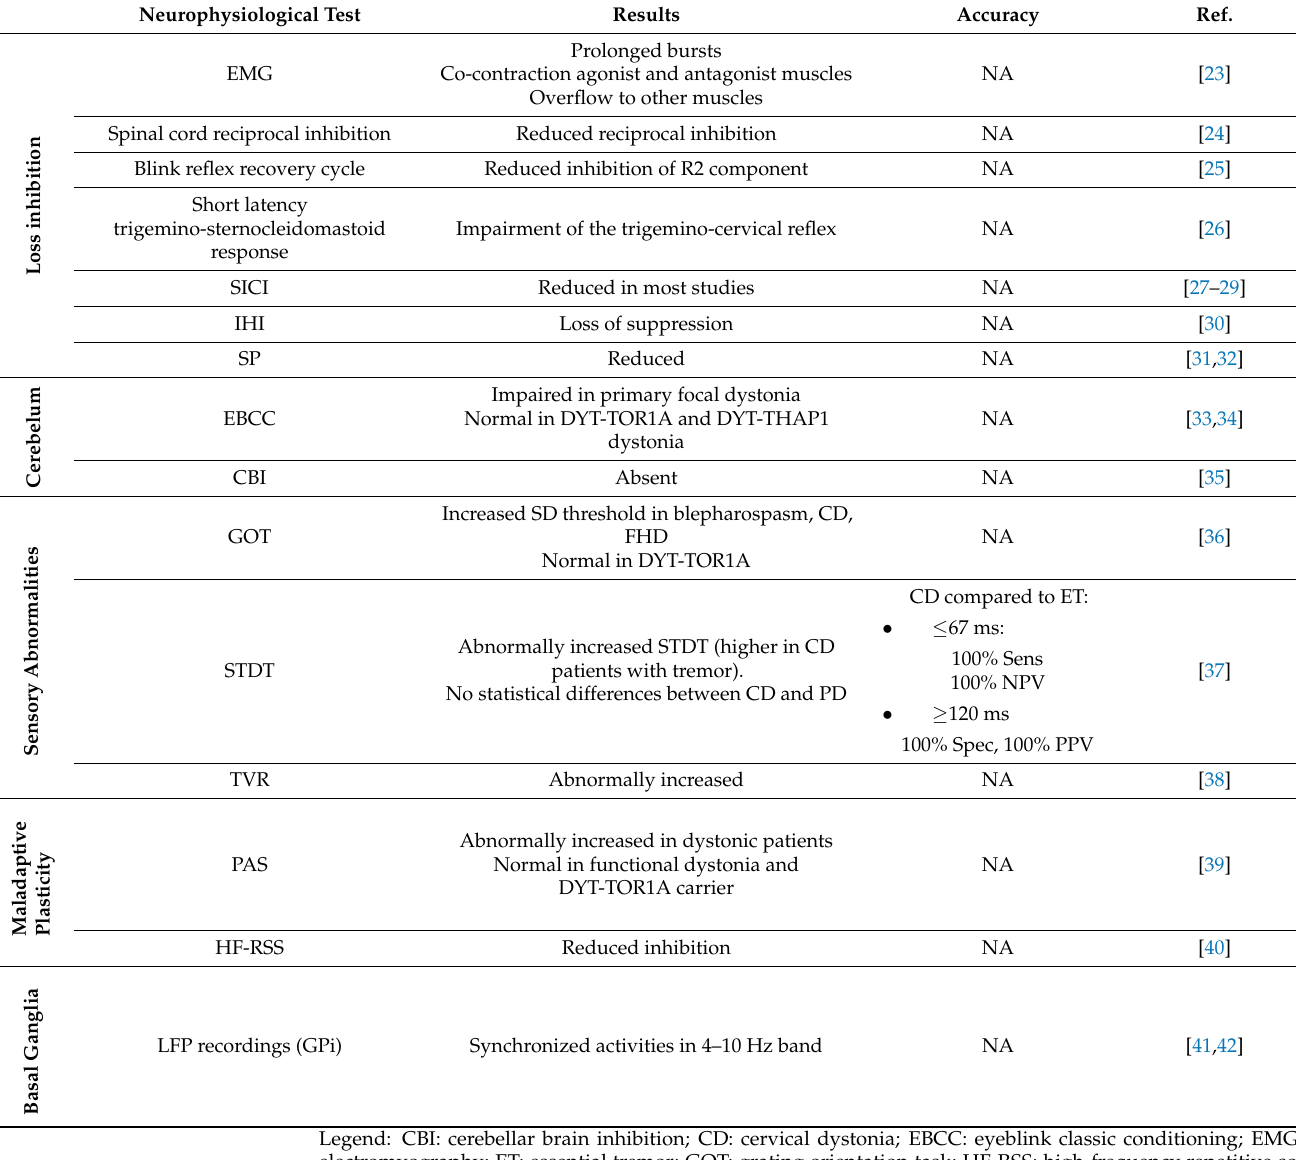
Table 1. Main neurophysiological findings in